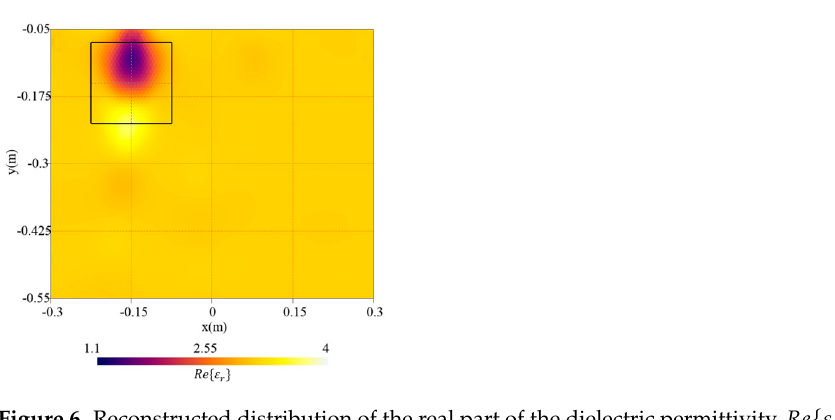
Figure 5. Relative reconstruction errors in all of the investigation domain R and inside the target region versus the exponent range, defined by the parameter p min .